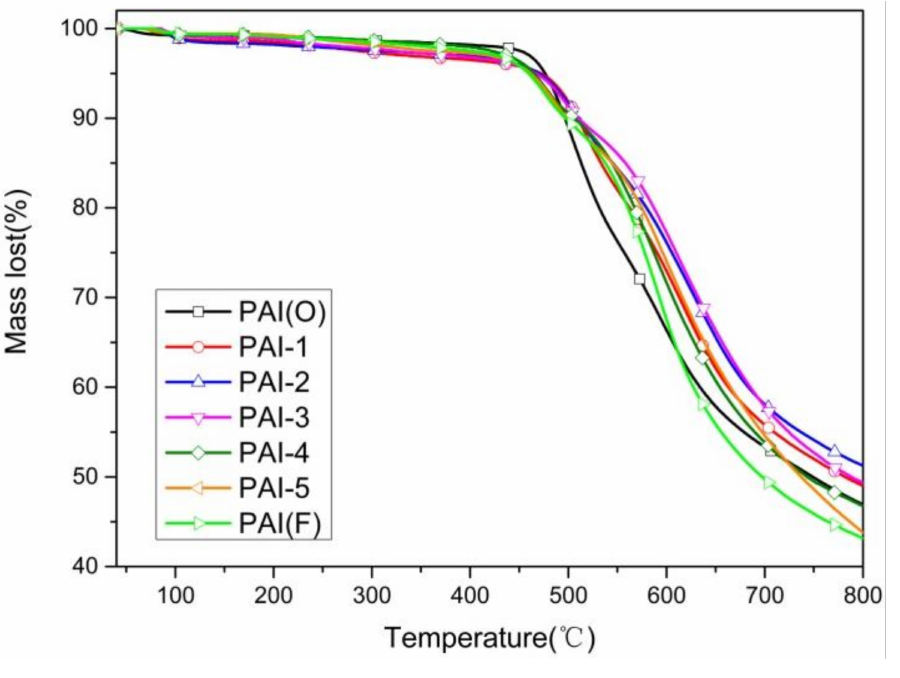
Figure 4. TGA curve of synthetic PAI materials. Table 3. Td 5% of synthesized PAI materials.